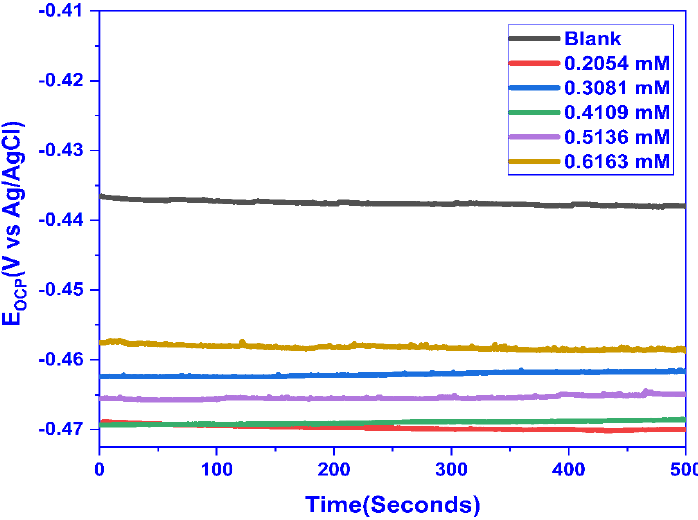
Table 4. PDP parameters for MS corrosion in 1 M HCl in the absence and presence of various doses of CMEA at 30 °C.